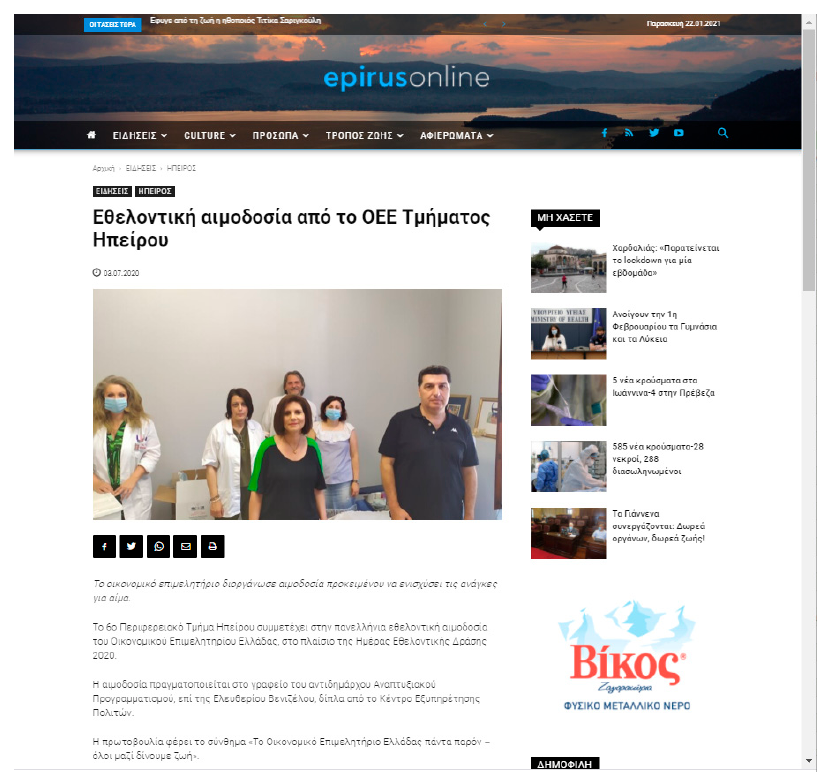
Figure 1. A news article from epirusoline (https://epirusonline.gr/eidiseis/ipeiros/ethelontiki-aimodosia-apo-to-oee- tmimatos-ipeiroy/ accessed on 7 February 2021).